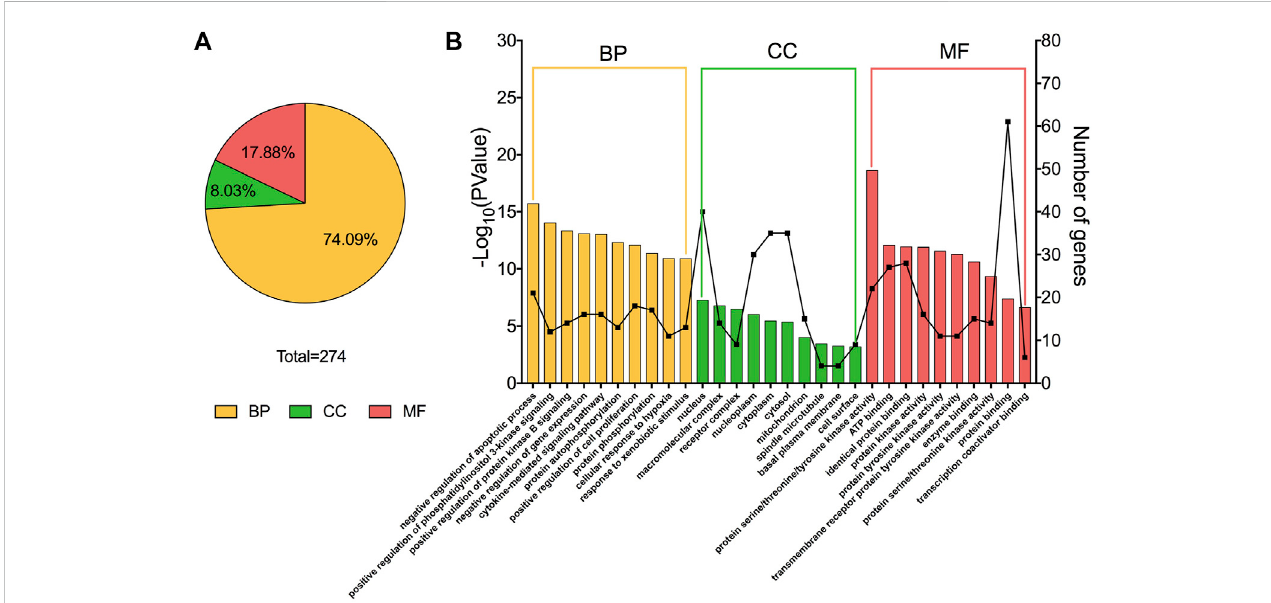
FIGURE 2 GO enrichment analysis results. (A) The percentage of biological process (BP), cellular component (CC), and molecular function (MF) entries in total GO entries ( p < 0.05). (B) The top 10 entries of BP, CC and MF, included their gene number, ranked from left to right by − log10 ( p -value).